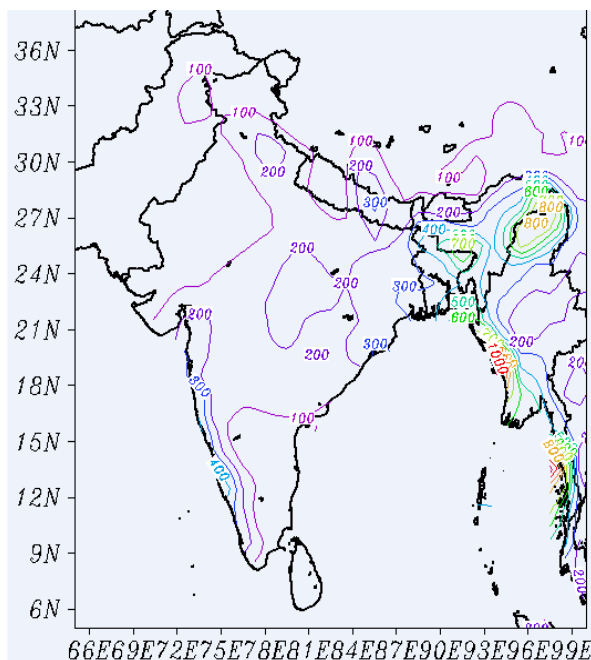
Fig. 13. NCEP rainfall (mm) 2003 (JJAS).